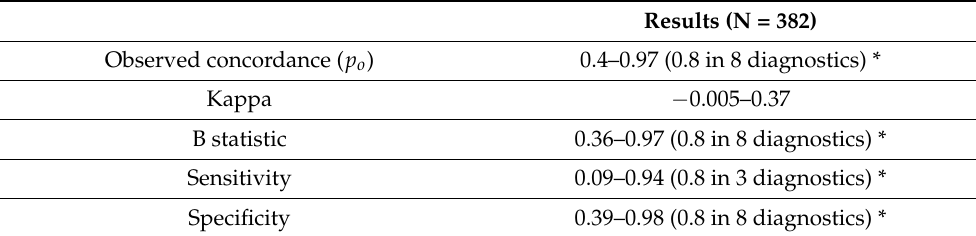
Table 4. WW precision and accuracy comparing the first 5 WtsWrng presumptive diagnoses and the diagnosis in ED clinical records at